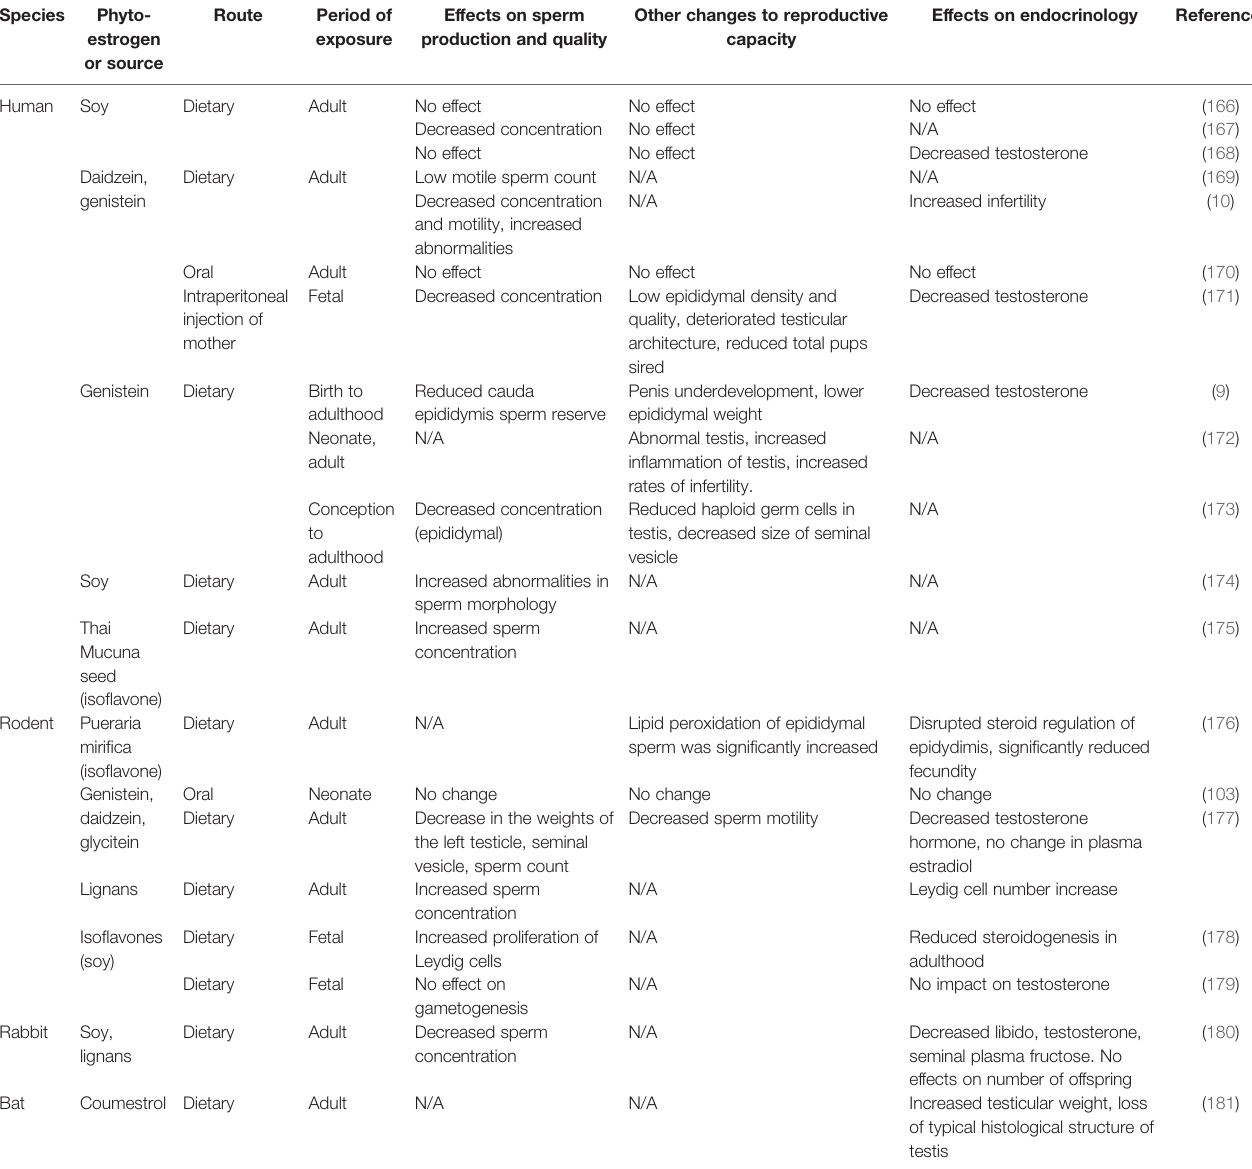
TABLE 3 | The effect of phytoestrogen exposure on male reproductive function across several species and routes of exposure. Species Phyto-